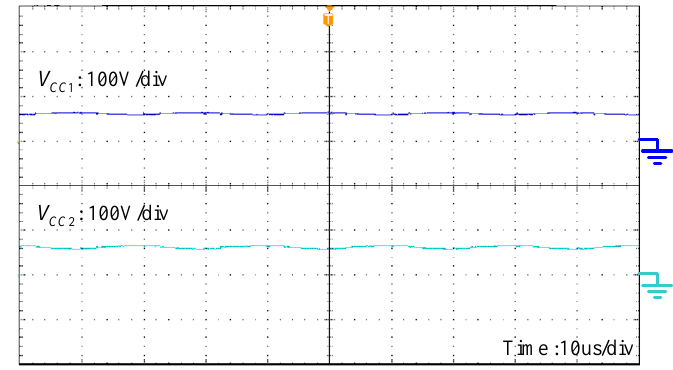
Figure 10. Measured waveforms of the voltages on the switched capacitors and the output capacitors.